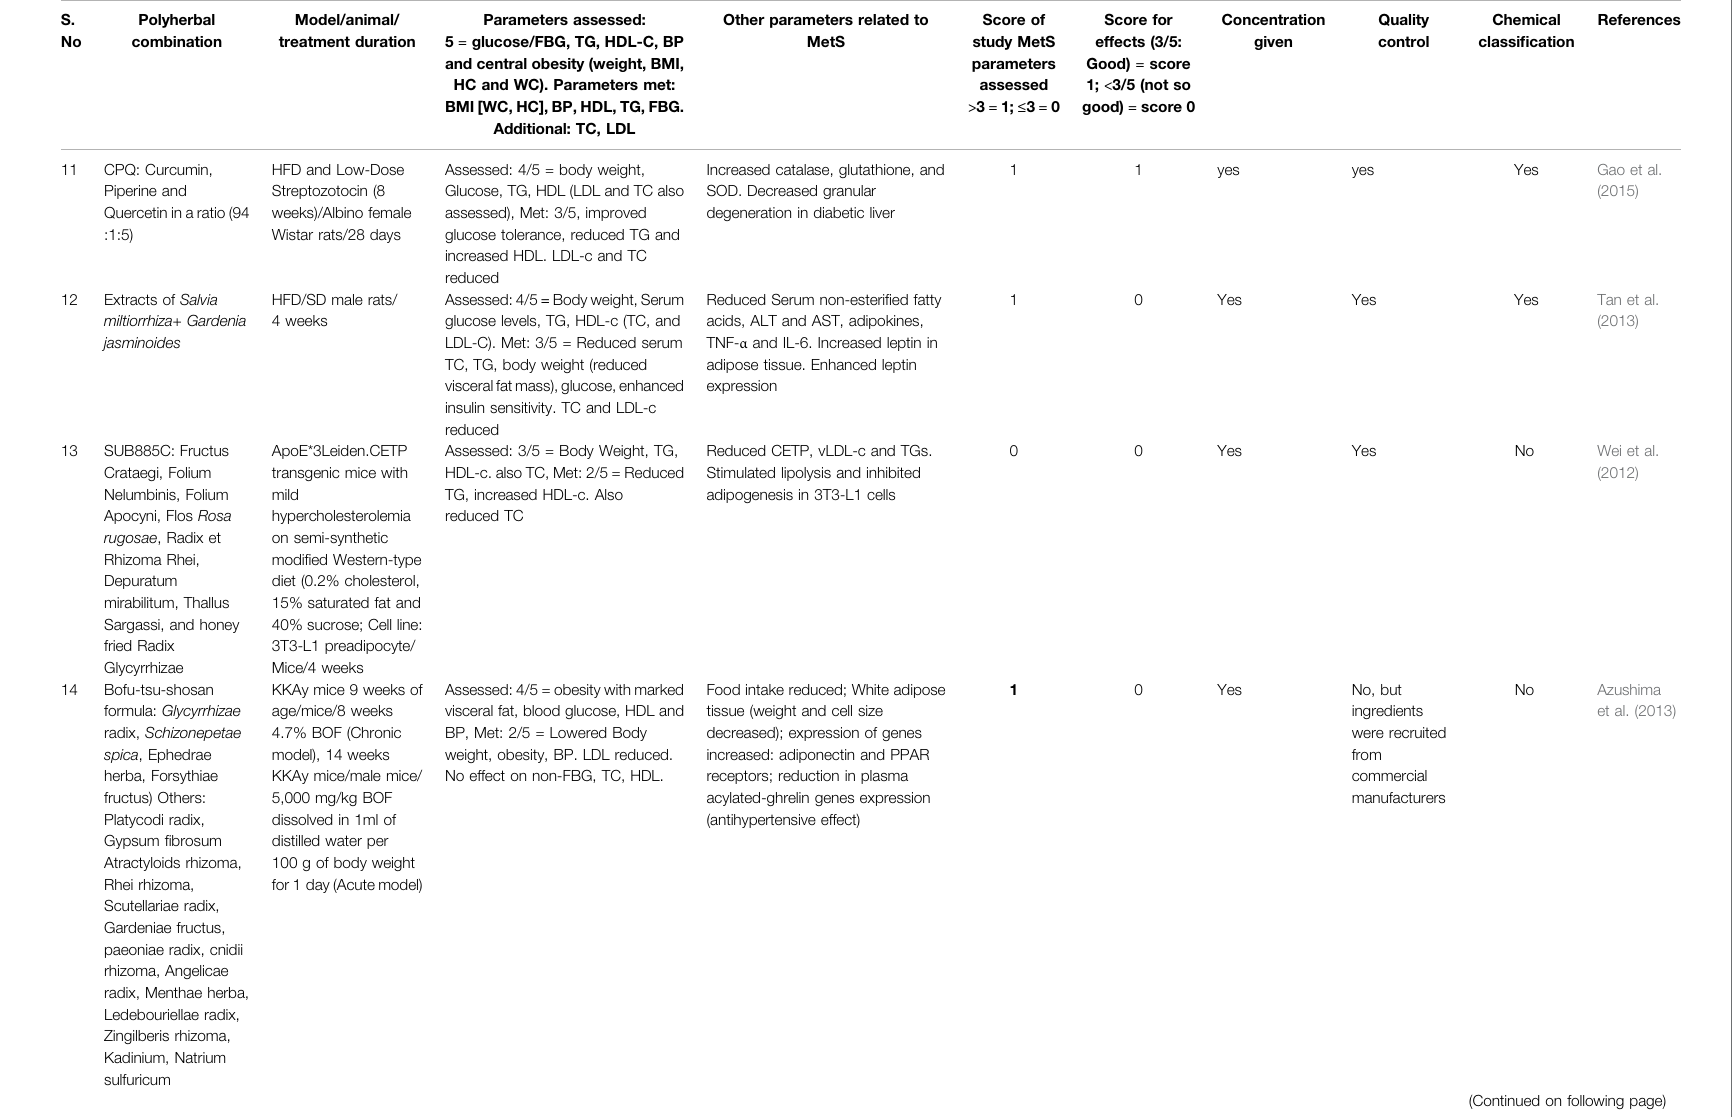
TABLE 3 | ( Continued ) Summary of metanalysis of Poly herbal combinations used in animal-based models of Metabolic syndrome. S.